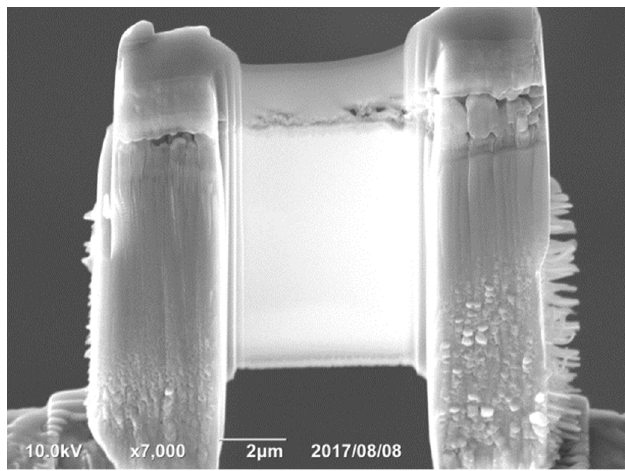
Figure 2. The sample for transmission electron microscopy after focused ion beam machining.